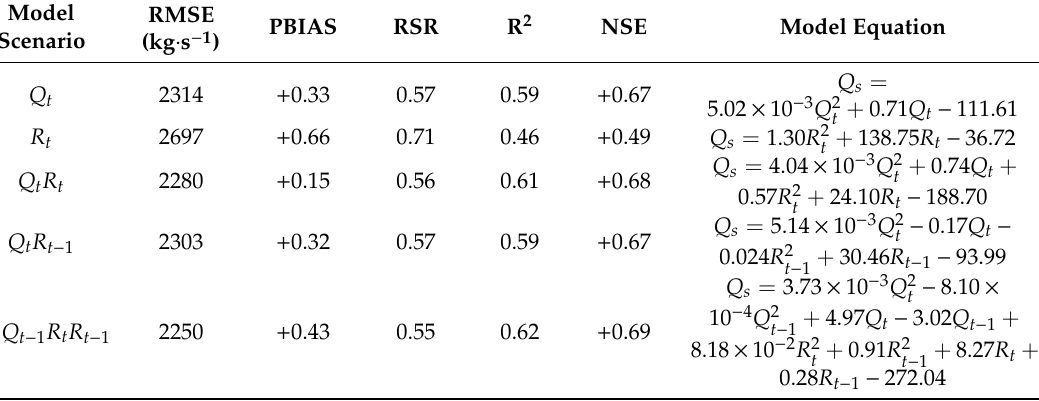
Table 3. NLMR models.